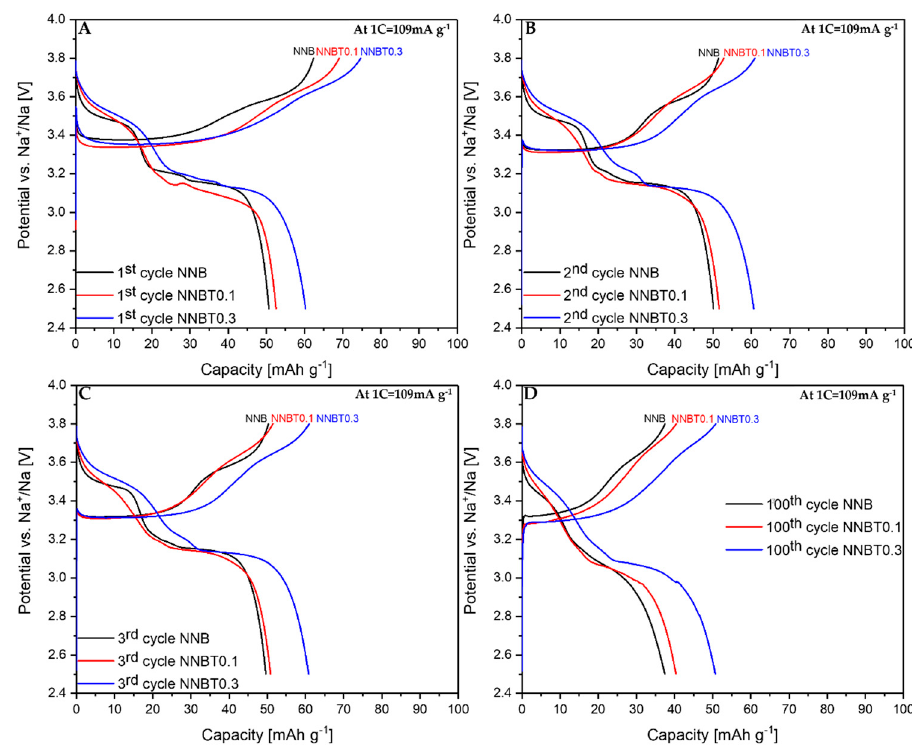
Figure 4. Galvanostatic desodiation / sodiation profiles at 1 C for 1st ( A ), 2nd ( B ), 3rd ( C ) and 100th ( D ) cycles of NNB, NNBT0.1 and NNBT0.3.